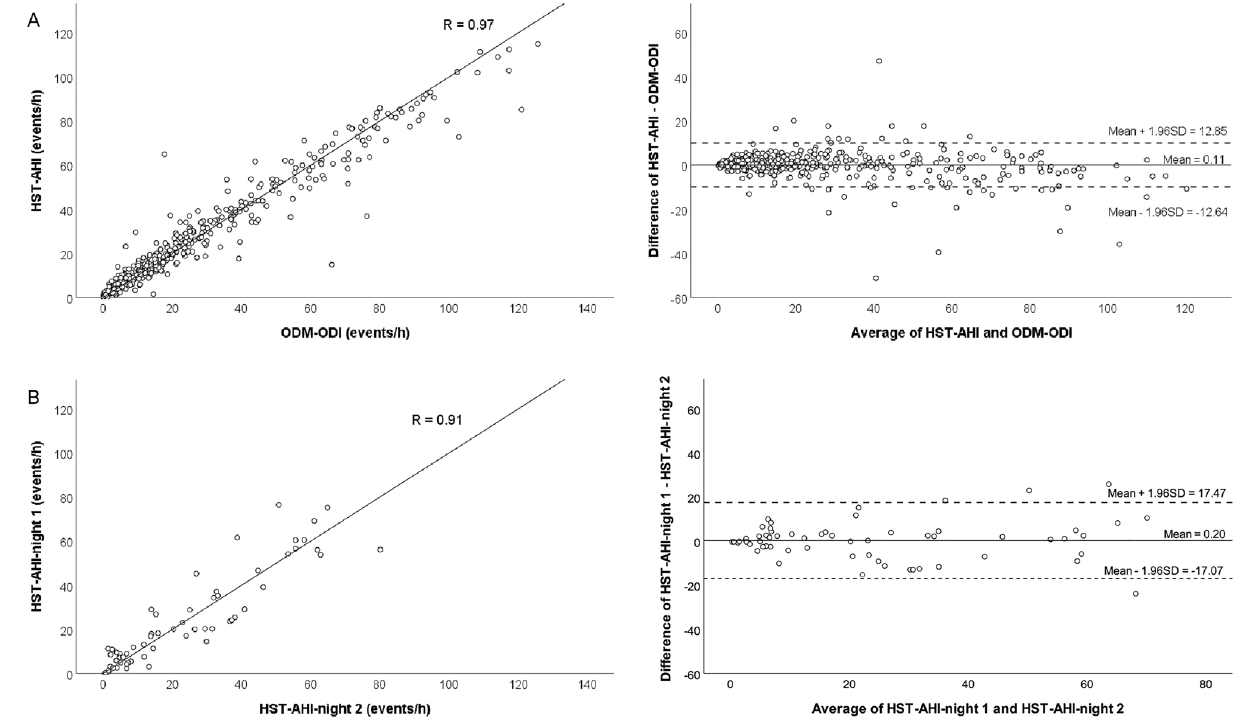
Figure 3. Scatter plots and Spearman’s correlation (r) and Bland–Altman plots comparing ( A ) ODM-ODI and AHI-HST, ( B ) Night 1 and Night 2 HST-AHI.